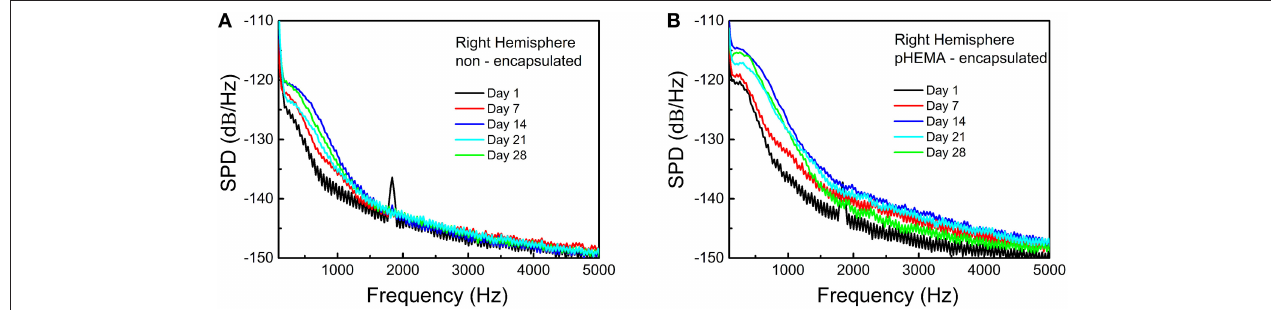
FIGURE 7 | SPDs obtained for the non-filtered spontaneous activity recorded from the rat brain using non-encapsulated PEDOT-PSS-CNT (A) and pHEMA-encapsulated (B) microspheres at 1, 7, 14, 21, and 28 days after the implant.